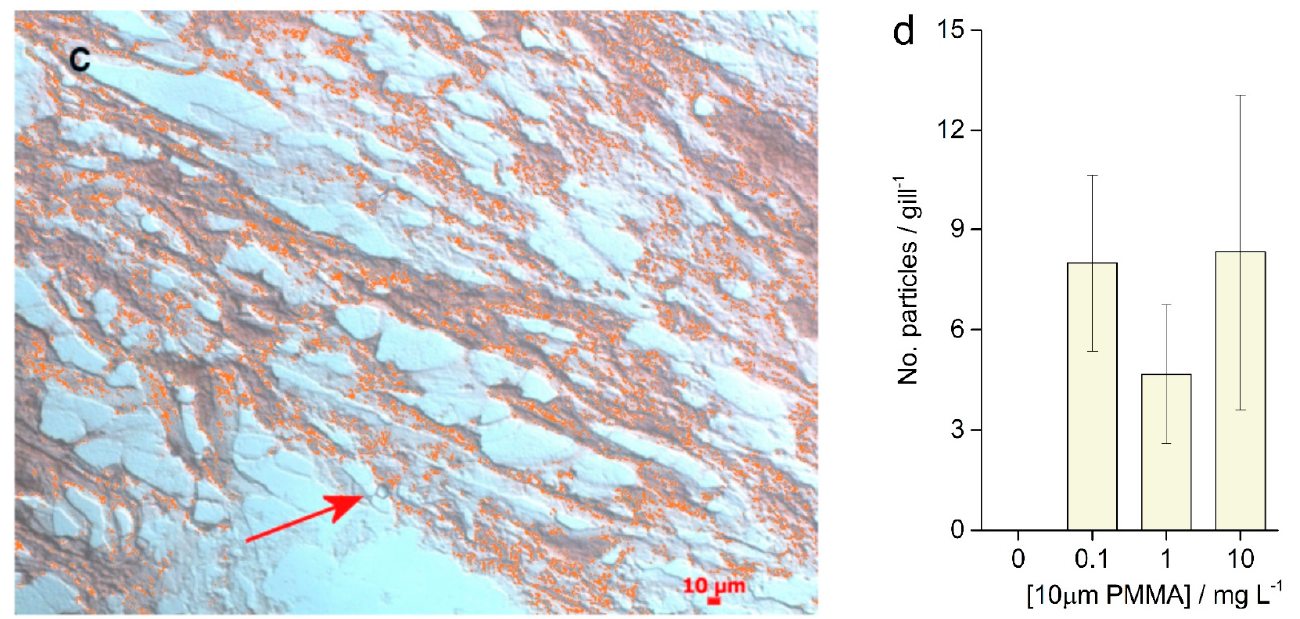
Figure 8. Micrographs of 10 μ m microparticles in a cryosection of the ( a ) hepatopancreas (scale bar 20 μ m) and ( c ) gill (arrow indicates microparticle; scale bar 10 μ m) for mussels exposed to 10 mg L − 1 (HIGH) PMMA, and particle counts (mean ± SD) in ( b ) hepatopancreas and ( d ) gill cryosections for mussels exposed to 0.1 mg L − 1 (LOW), 1.0 mg L − 1 (MID) and 10 mg L − 1 (HIGH) microparticles.